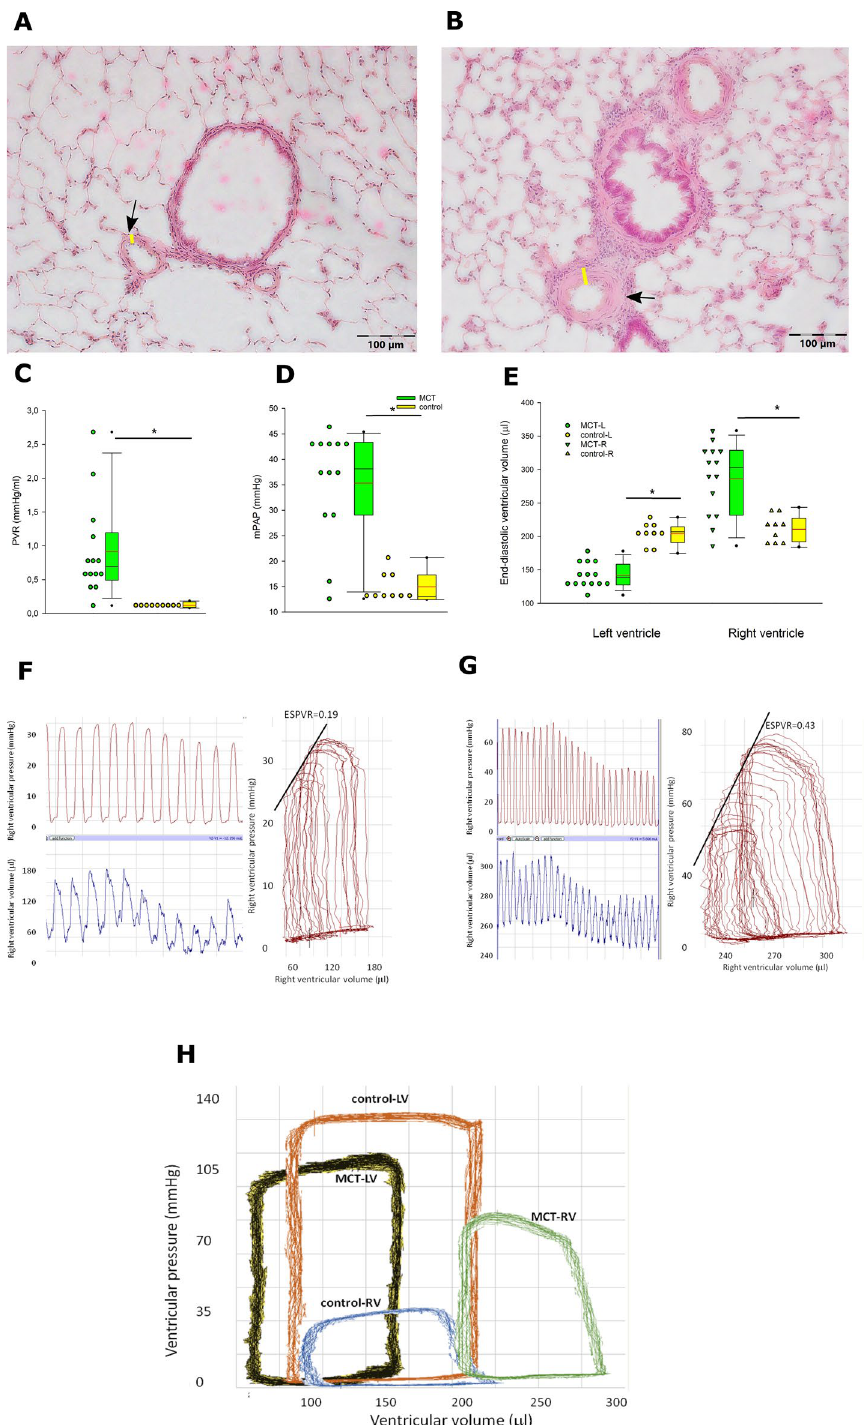
Figure 1. Histological and hemodynamic characterization of rats with monocrotaline-induced pulmonary hypertension and control rats. Representative hematoxylin and eosin stained images from control ( A ) and monocrotaline (MCT)-treated ( B ) rats, demonstrating small pulmonary arterioles (arrows). Yellow bars indicate arteriolar wall thickness. Clear wall thickening and luminal stenosis can be seen in a MCT rat. ( C ) demonstrates pulmonary vascular resistance (PVR), ( D ) mean pulmonary artery pressure (mPAP), and ( E ) left and right ventricular end-diastolic volumes. Representative right ventricular pressure–volume loops and tracings of right ventricular pressure and volumes are presented for control ( F ) and MCT ( G ) rats. ( H ) presents representative RV and LV PV loops from control and MCT rats. Horizontal lines represent mean (red) and median (black), the bottom and the top of the boxes represent the upper and the lower quartile, he whiskers represent 10th and 90th percentile, while the solid circles represent the individual data points. ( C – E ) control n = 9; MCT n = 14; since the data exhibited non-normal distribution, the groups were compared using Mann–Whitney test; * p <